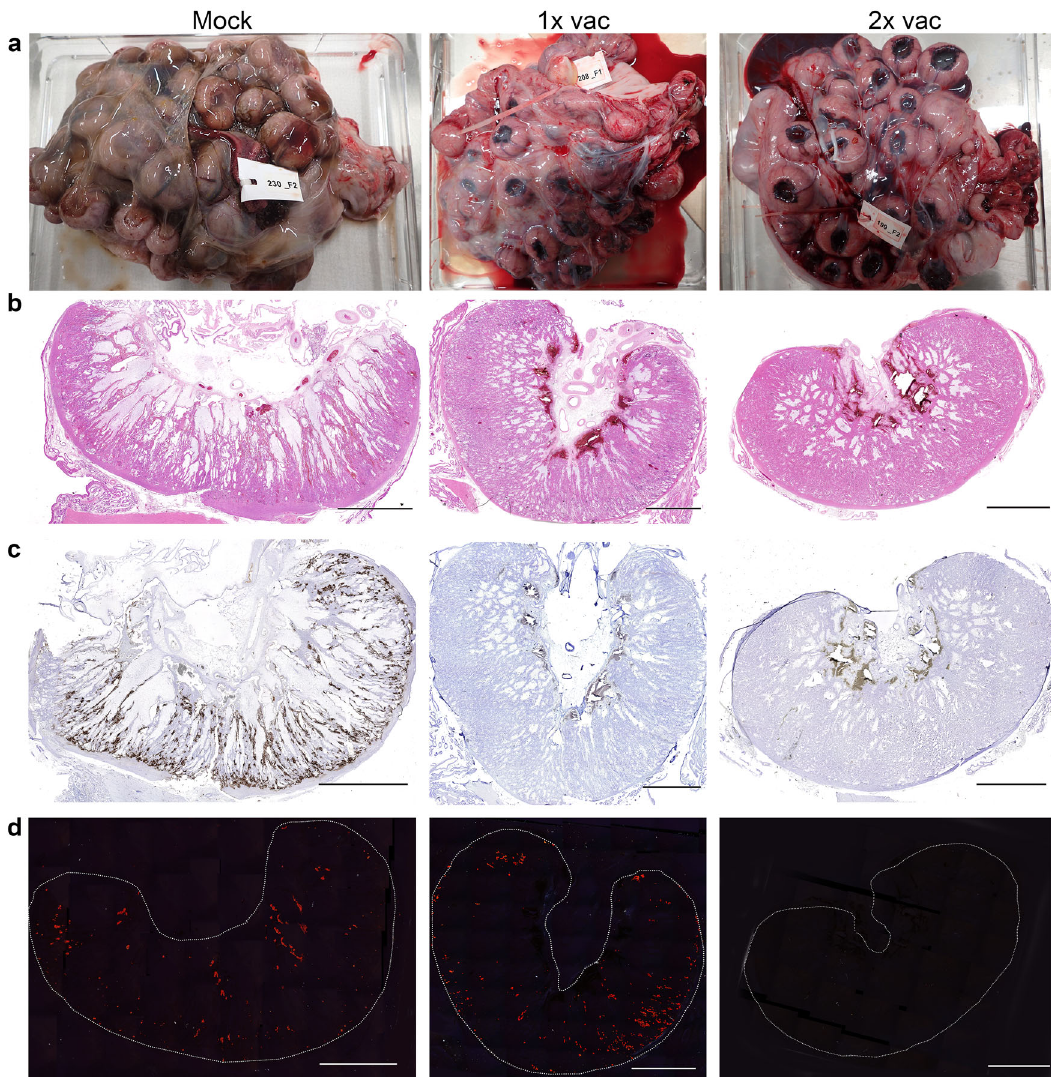
Fig. 4 Macroscopic assessment of placentas and histopathology of placentomes from mock-vaccinated ewes and ewes vaccinated with vRVFV-4s MSV + 5 and challenged with RVFV strain 35/74. a Placenta from a mock-vaccinated, challenged ewe (ewe #230, foetus #F2), euthanized at 7 days post challenge (left panel). Placenta from a 1× vaccinated ewe (ewe #208, foetus #F1), euthanized at 24 days post challenge (centre panel). Placenta from a 2× vaccinated ewe (ewe #199, foetus #F2) euthanized at 21 days post challenge (right panel). b H&E staining of representative placentome sections, c IHC staining of placentome sections with RVFV-speci fi c mAb 4-D4, d Alizarin Red staining of placentome sections visualised using polarised light. Bars represent 5